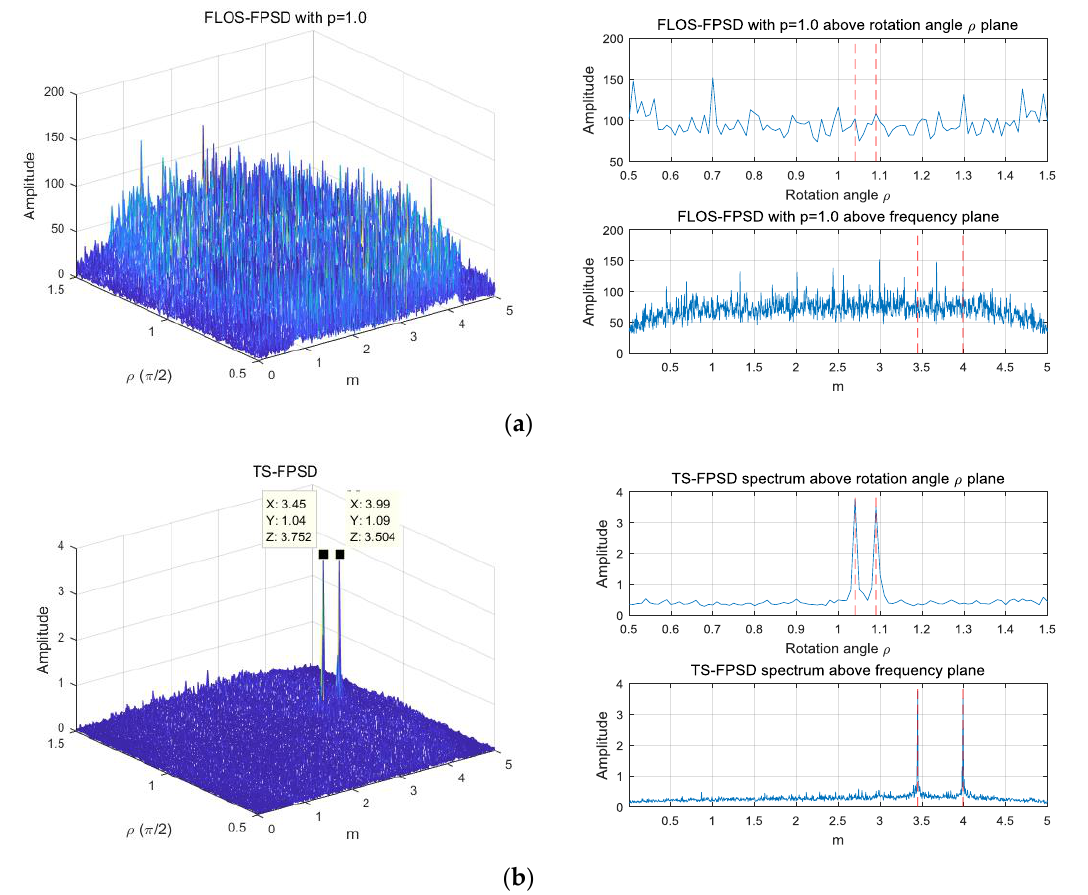
Figure 9. The spectrum of FPSD, FLOS-FPSD, and TS-FPSD under the S α S noise with GSNR = 5dB and α = 1.1; ( a ) The FLOS-FPSD with p = 1.0 spectrum of the echo, and its rotation angle plane and the frequency plane; ( b ) The TS-FPSD spectrum of the echo, and its rotation angle plane and the frequency